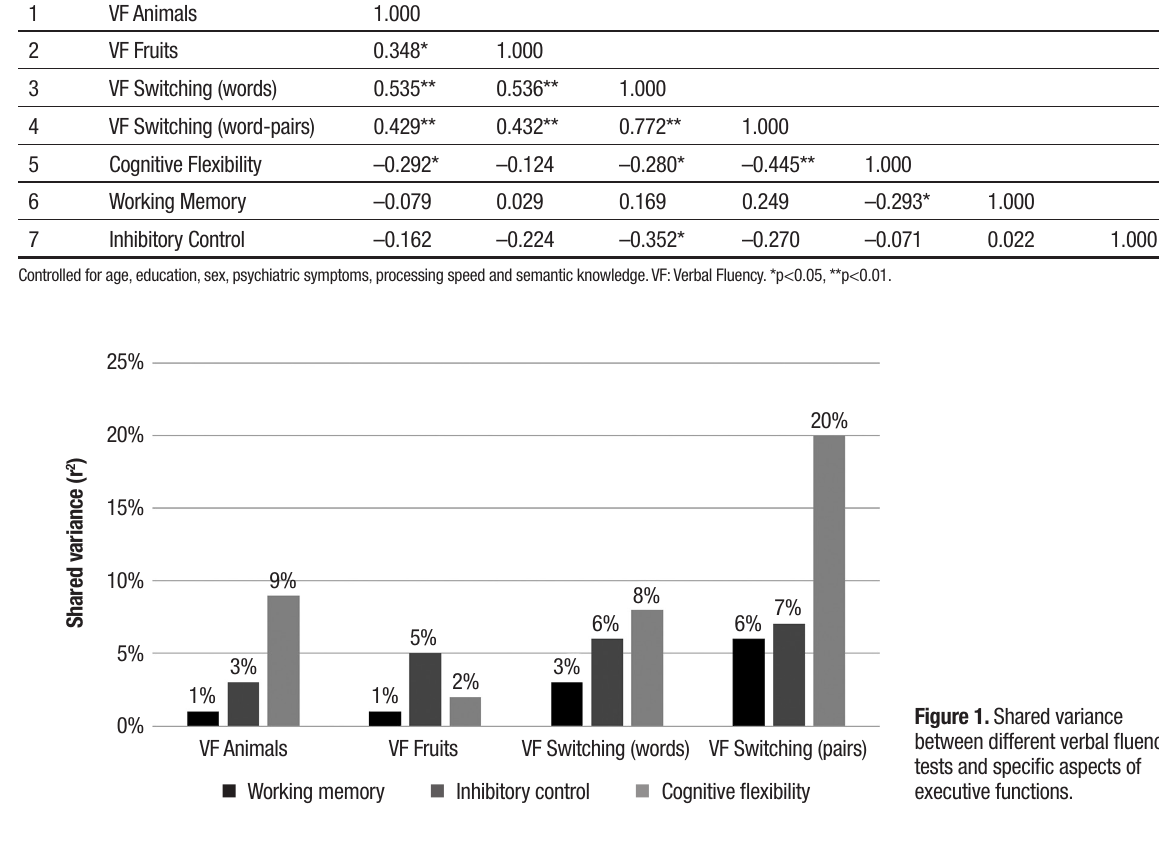
Table 3. Partial correlations between verbal fluency tests and different aspects of executive functions. Test